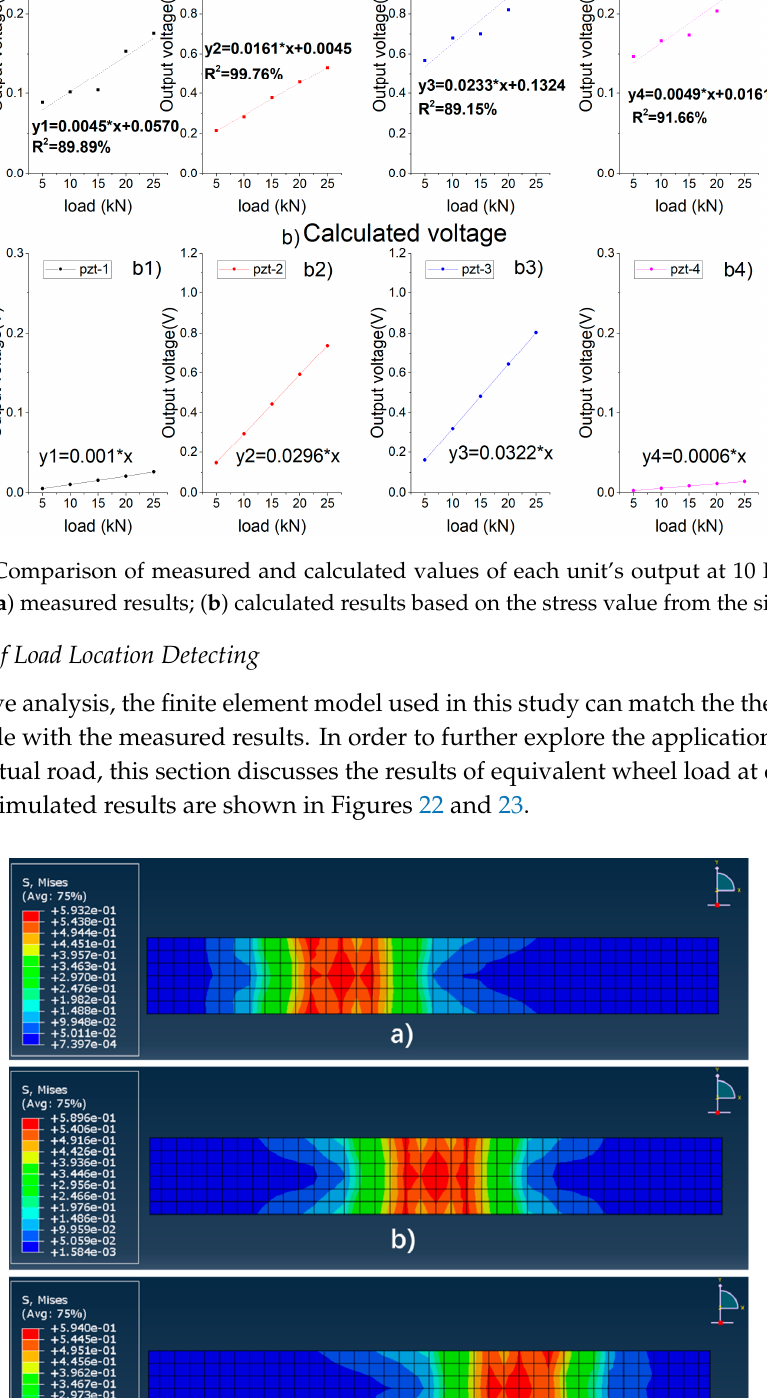
Figure 23. Output of the system changing with loading position. ( a ) Load on the zone in the middle of 1# and 2# (Left); ( b ) load on the zone in the middle of 2# and 3# (Middle); ( c ) load on the zone in the middle of 3# and 4# (Right); ( d ) comparison of the total output at different load locations.